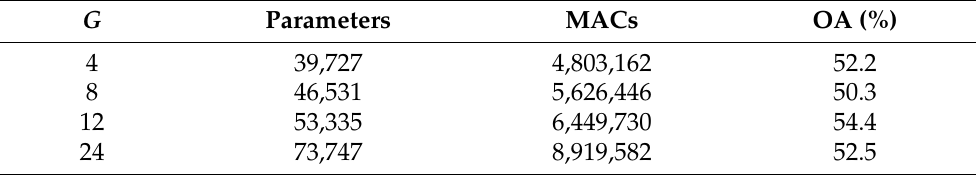
Table 8. Classification performance and the number of parameters and MACs of the proposed DRIN with different G values on the HyRANK